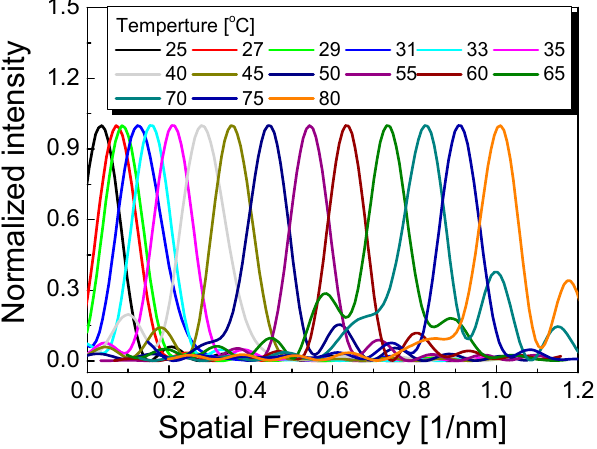
Figure 5. Spatial frequency spectra of the polymer-overlaid microfiber MZI with variations in temperature.